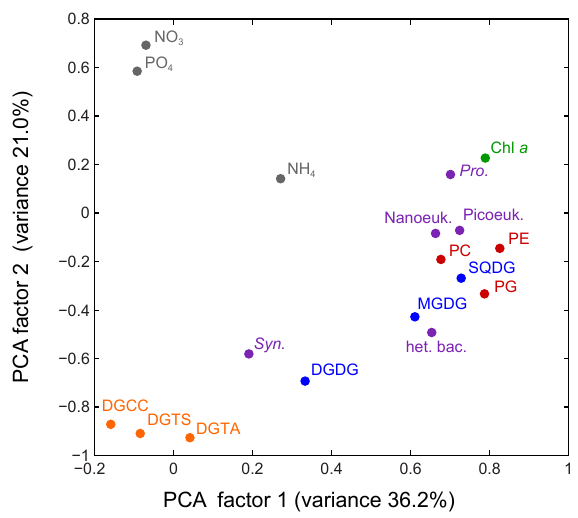
Fig. 5. Principal component analysis was applied to 18 parameters: concentration of three phospholipids (PG, PE, PC; red circles); con- centration of three glycolipids (SQDG, MGDG, DGDG; blue cir- cles); concentration of three betaine lipids (DGTA, DGTS, DGCC; orange circles); abundance of five plankton populations (purple cir- cles): Synechococcus ( Syn. ), Prochlorococcus ( Pro. ), nanoeukary- otic phytoplankton (nanoeuk.), picoeukaryotic phytoplankton (pi- coeuk.), heterotrophic bacteria (het. bac.); concentration of three nutrients (grey circles); and concentration of total chlorophyll- a (Chl- a ; green circle). Each parameter is plotted as its loading on the two principal component factors that captured the greatest amount of variance in the